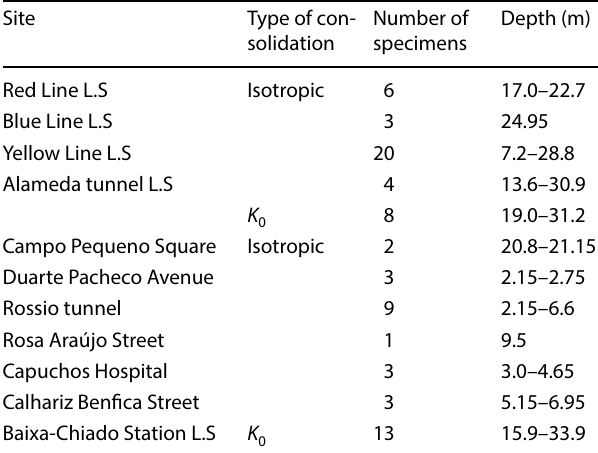
Table 1 Summary of triaxial compression tests selected from exist‑ ing reports